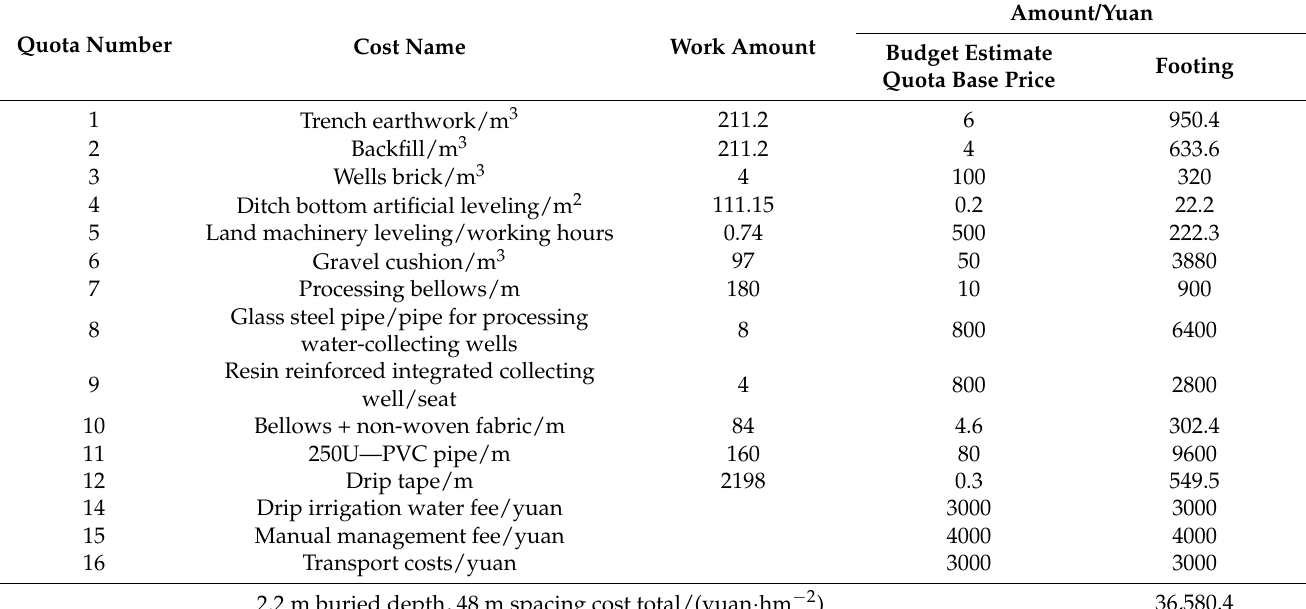
Table 5. Comprehensive cost schedule of the subsurface pipe construction